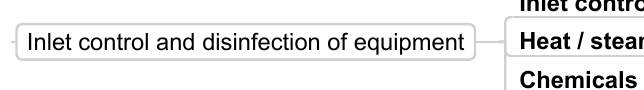
Figure 3. Partial taxonomy: Disinfection of equipment.